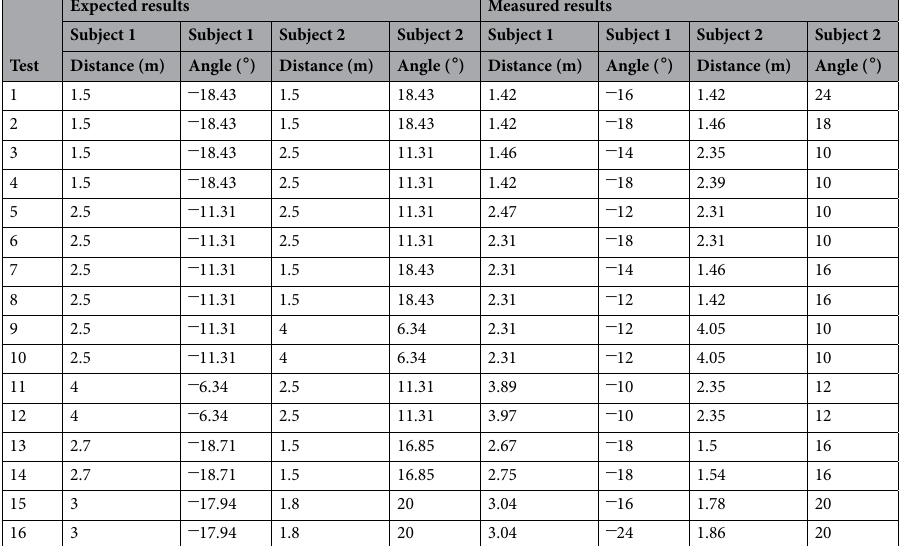
Table 1. Results of the experimental validation.